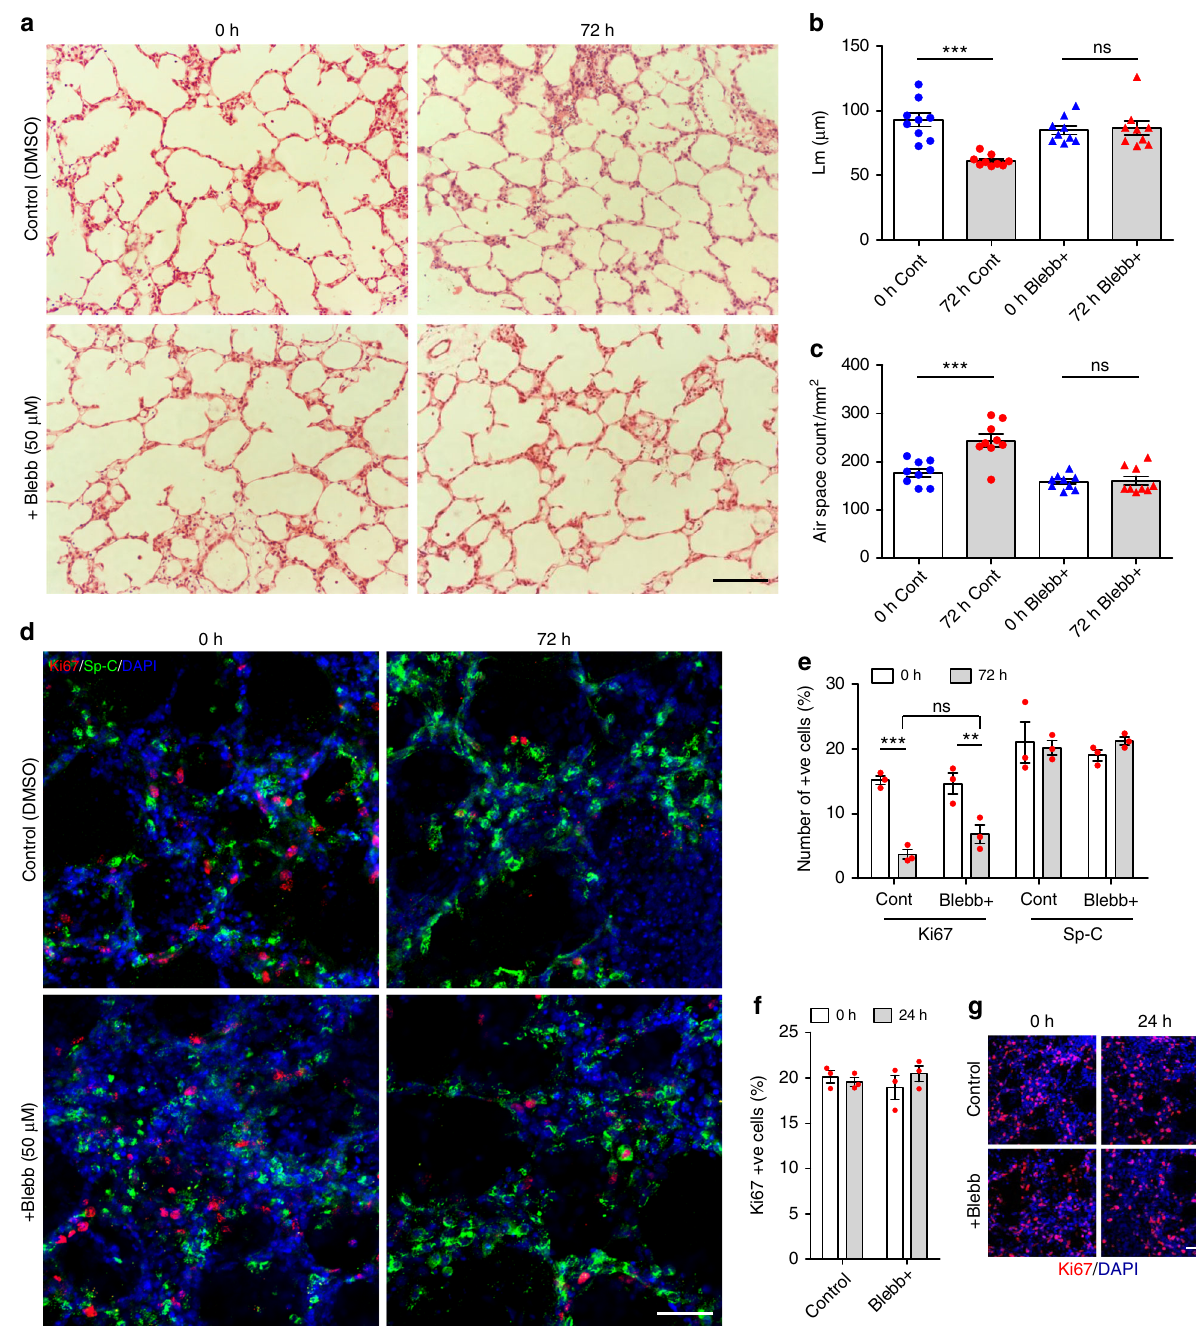
Fig. 7 Blebbistatin inhibits ex vivo alveologenesis. H&E stained sections from P3 PCLS at 0 and 72 h, cultured with DMSO control (top panels) or 50 μ M blebbistatin (bottom panels) ( a ). Scale bar = 100 µ m. Mean linear intercept (Lm) ( b ) and airspace count ( c ) obtained from H&E sections of P3 PCLS treated with DMSO control or 50 μ M blebbistatin at 0 and 72 h, n = 3 independent experiments using 3 separate mice, 3 H&E sections from each PCLS from each mouse were quanti fi ed per group, per experiment, each dot represents per fi eld count ( b , c ); *** p < 0.001, ns = not signi fi cant, one-way ANOVA with Tukey ’ s post hoc test. Confocal single plane z-stack images of DMSO control (top panels) and 50 µ M blebbistatin (bottom panels) P3 PCLS at 0 and 72 h culture, immunostained with Ki67 (red), Sp-C (green) and DAPI (blue) ( d ). Scale bar = 50 µ m. Quanti fi cation of Ki67 and Sp-C + ve cells in control and blebbistatin-treated P3 PCLS at 0 and 72 h culture ( e ), n = 3 independent experiments using 3 separate mice, with duplicate slices per group per experiment. Two fi elds were quanti fi ed per slice. Each dot represents mean value of per fi eld counts per experiment; ** p < 0.01; *** p < 0,001; ns = not signi fi cant; one-way ANOVA with Tukey ’ s post hoc test. Quanti fi cation of Ki67 + ve cells in DMSO control and blebbistatin-treated P3 PCLS at 0 and 24 h in culture ( f ), n = 3 independent experiments using 3 separate mice, with duplicate slices per group, per experiment. Two fi elds were quanti fi ed per slice. Each dot represents mean value of per fi eld counts, per experiment; one-way ANOVA with Tukey ’ s post hoc test. Confocal single plane z-stack images of DMSO control (top panels) and 50 µ M blebbistatin-treated (bottom panels) P3 PCLS at 0 and 24 h culture, immunostained with Ki67 (red) and DAPI (blue) ( g ). Scale bar = 50 µ m. Error bars are de fi ned as